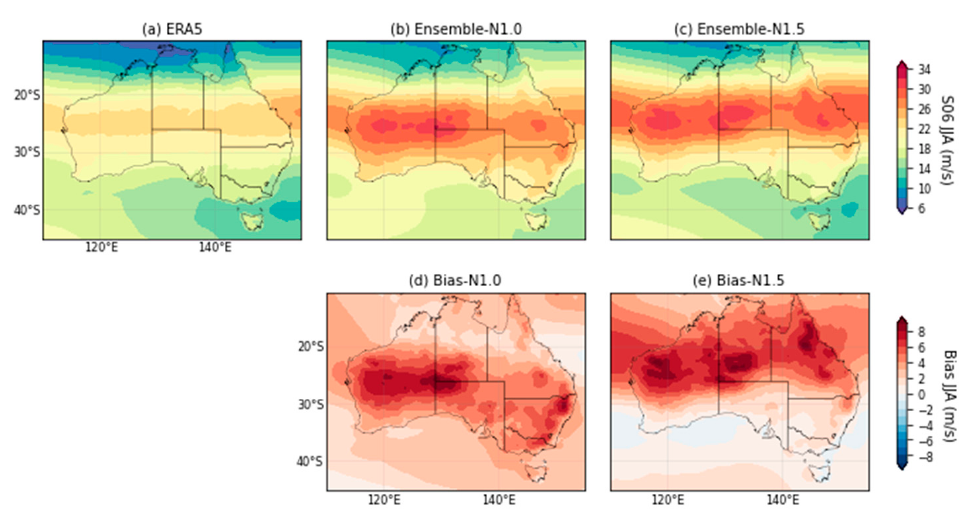
Figure A14. As in Figure A11 except for JJA.